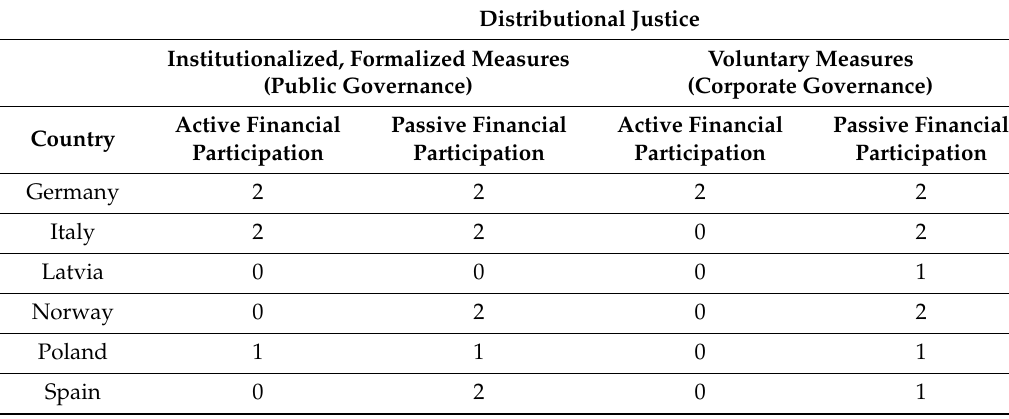
Table 3. Comparative analysis of institutionalized / formalized and voluntary measures promoting financial participation of citizens in the six WinWind partner